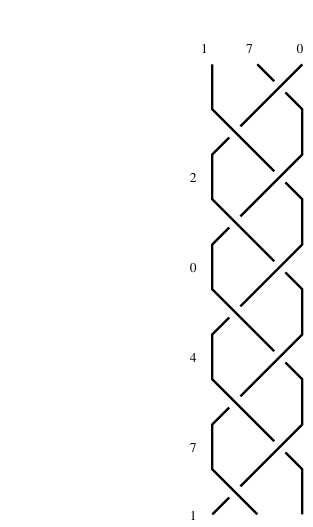
Fig. 5: Illustrative examples of non-trivial colorings of THK (3 , n ) ’s (cont’d). A 3 -coloring of THK (3 , 4) with 3 colors and an 11 -coloring of THK (3 , 5) with 5